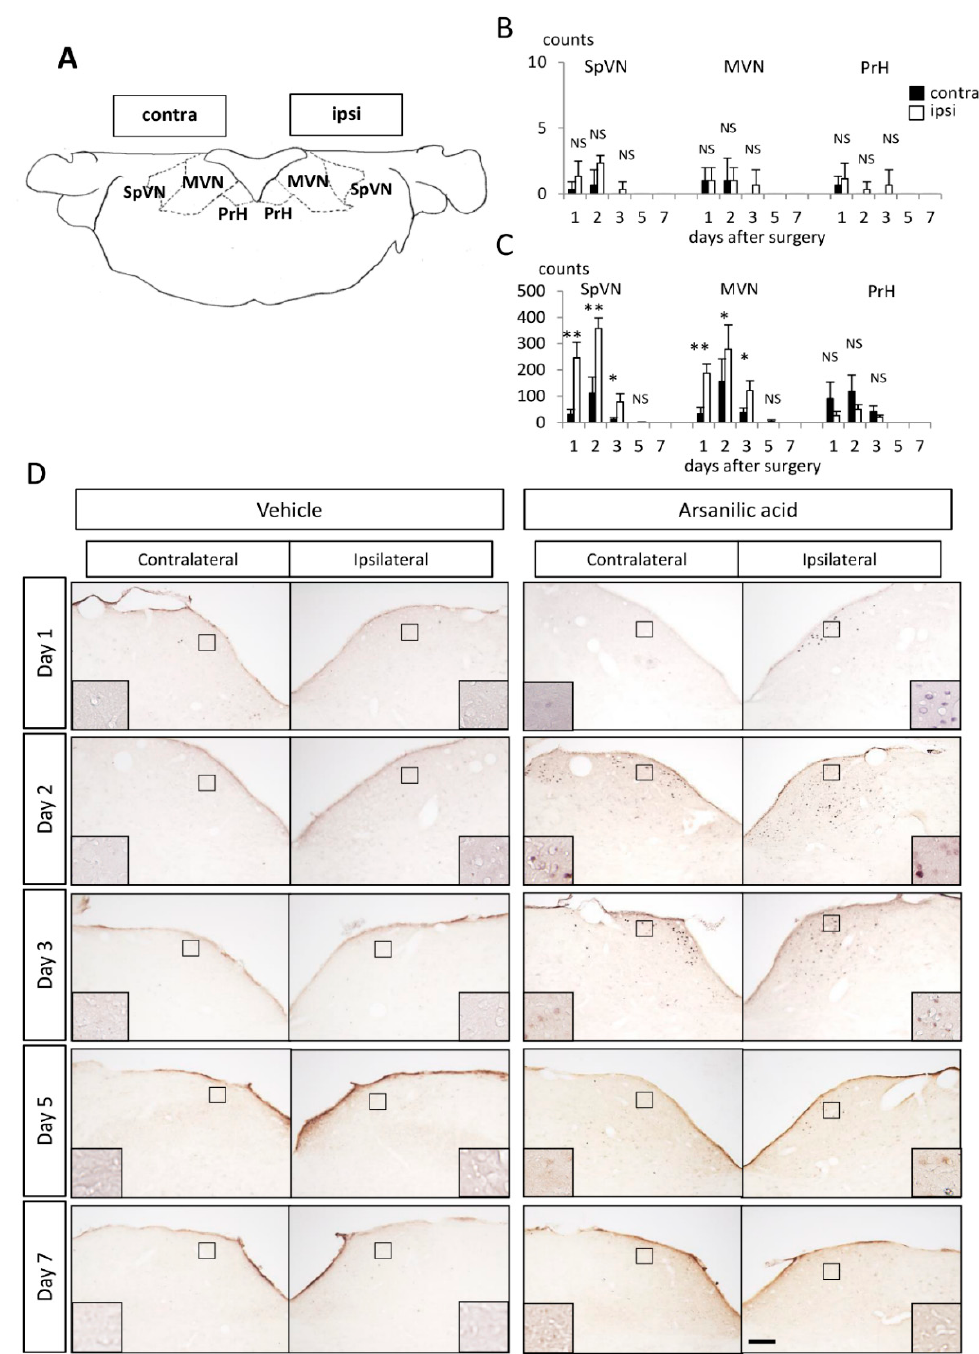
Figure 4. Expression of c-Fos-IR cells in the ipsilateral and contralateral spinal vestibular nucleus (SpVN), medial vestibular nucleus (MVN), and prepositus hypoglossal nucleus (PrHN). ( A ) Vestibular nucleus. ( B ) Number of c-Fos-IR cells in the vestibular nucleus in the vehicle (unilateral labyrinthectomy with phosphate buffer) group. ( C ) Number of c-Fos-IR cells in the vestibular nucleus in the arsanilic acid (unilateral labyrinthectomy with arsanilic acid) group. ( D ) Expression of c-Fos-IR cells in the vestibular nucleus. There are few c-Fos-IR cells in SpVN / MVN / PrHN in the vehicle group ( B , D ). In the ipsilateral and contralateral SpVN / MVN / PrHN in the arsanilic acid group, a substantial number of c-Fos-IR cells can be seen on day 1 after surgery, with a maximum increase in number at 2 days and a gradual decrease to zero by 7 days ( C , D ). * p < 0.05, ** p < 0.01. NS, not significant; one-way analysis of variance (ipsilateral vs. contralateral); c-Fos-IR cells were predominantly found in the ipsilateral SpVN and MVN and the contralateral PrHN. The box inserts show representative c-Fos-IR cells. Scale bar, 50 µm at lower magnification.